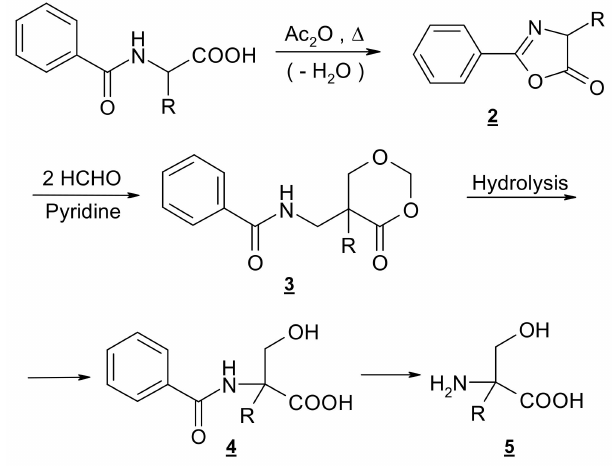
Scheme 1. Outline of the s ynthesis of compound 1